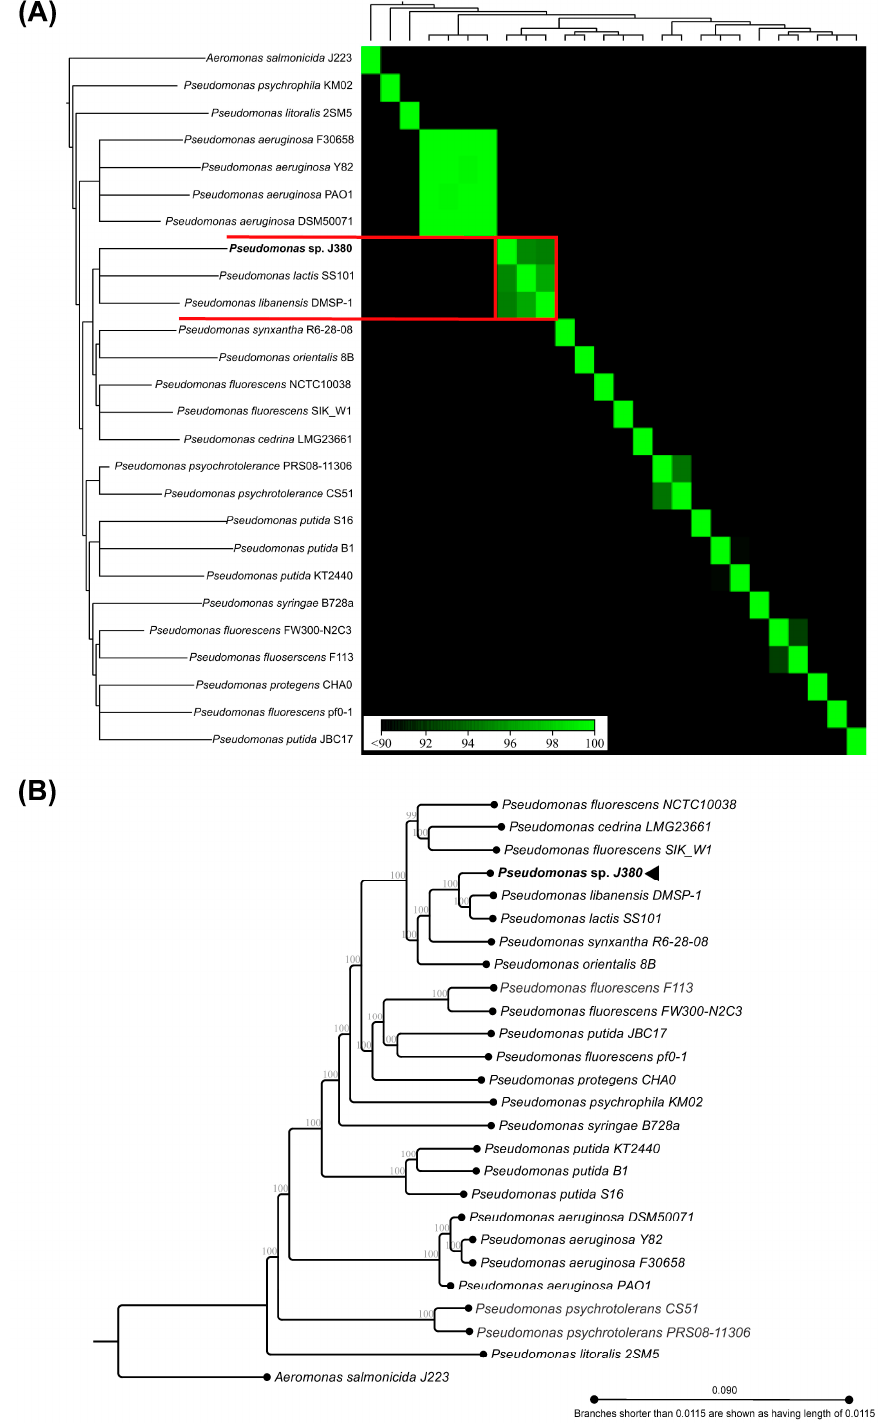
Figure 5. Comparative and phylogenomic analyses revealing clustering of Pseudomonas sp. J380 with members of P. fluorescens species complex. ( A ) Strain correlation matrix based on alignment and average nucleotide identity (ANI). The distance was calculated using the Euclidean algorithm, and the linkage criterion utilized was complete linkage. The color bar below represents the percentage of identity between strains. ( B ) Evolutionary history inferred using the neigh-bor-joining method with the bootstrap consensus from 1000 replicates. The evolutionary distance was computed using the Jukes–Cantor method. Whole-genome alignments and the phylogenetic analyses utilized 25 selected pseudomonad genomes listed in Table S2. Aeromonas salmonicida J223 was used as an